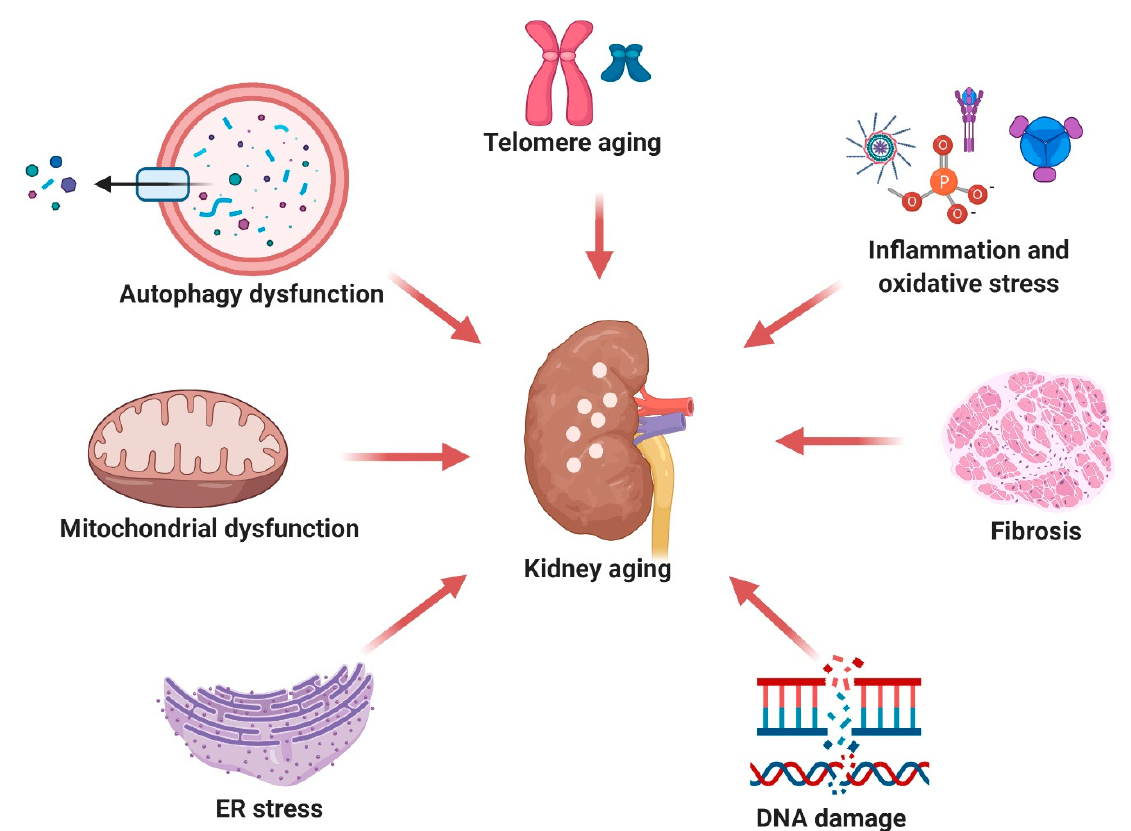
Figure 1. Pathological features of the kidney aging process. Kidney aging mainly occurs through several events in a sequential manner. These include (i) kidney fibrosis along with a reduction in cortical mass, increased glomerulosclerosis, and promptness of RAS; (ii) cellular senescence occurs through a persisting DNA damage response and an increase in interferon-gamma (IFN- γ ); (iii) mitochondrial damage induces an increased level of ROS through, which causes dysfunction with mitochondria; (iv) inflammation and oxidative stress are mediated through an increase in lipid peroxidation, NF- κ B activation, and glutathione depletion; (v) ER stress; (vi) autophagy dysfunction; and (vii) telomere shortening occurs by limiting transcription by DNA polymerase, leading to GFR diminution, decreased urinary concentration, reduced urinary acidification, impaired potassium clearance, increased vascular resistance, a contracted kidney mass, and blood flow.